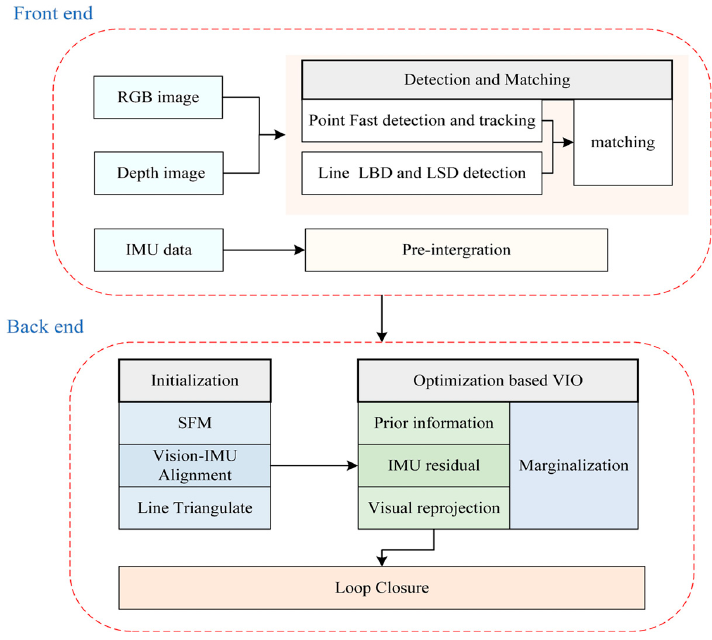
Figure 3. Overview of system structure.